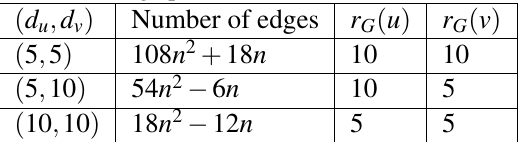
Fig. 4 Icosahedral network IS 3 Table 2 Edge partition of Icosahedral